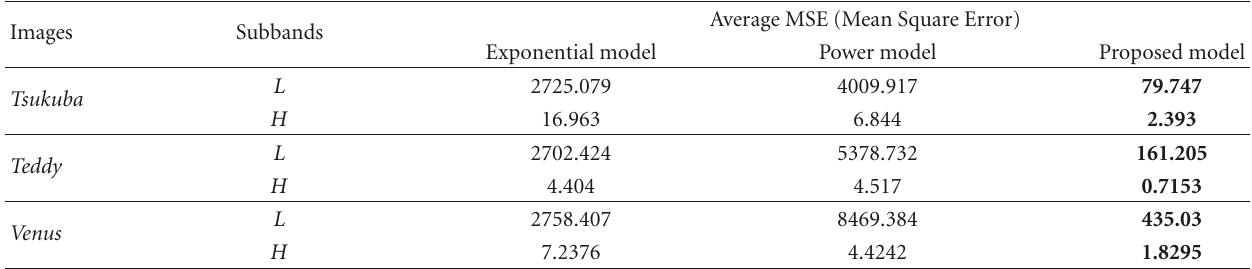
Table 3: The average of the mean square error (MSE) between the actual distortion and the computed distortion of di ff erent rate distortion models.